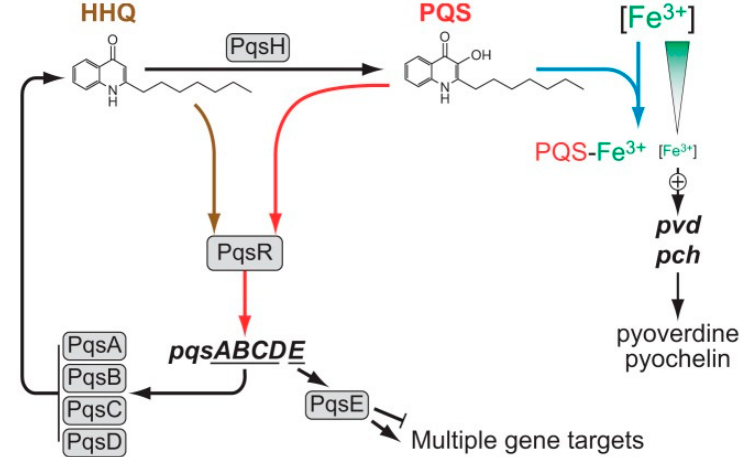
Figure 2. AQ-dependent quorum-sensing pathway in P. aeruginosa —transformation of HHQ to PQS. Action of the PqsABCD proteins result in HHQ, which is converted to PQS by PqsH. Autoinduction occurs when either HHQ or PQS binds to PqsR and amplifies the expression of the pqsABCDE operon. PqsE is a